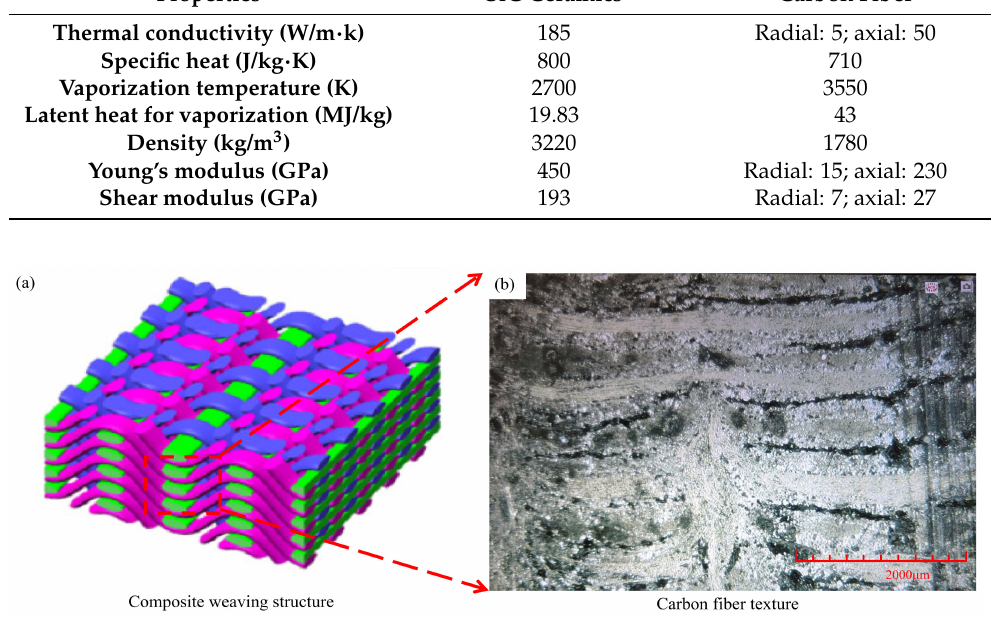
Figure 1. Structure of the 2.5-dimensional C f /SiC composite material (( a ). 2.5D structure diagram; ( b ). microscope